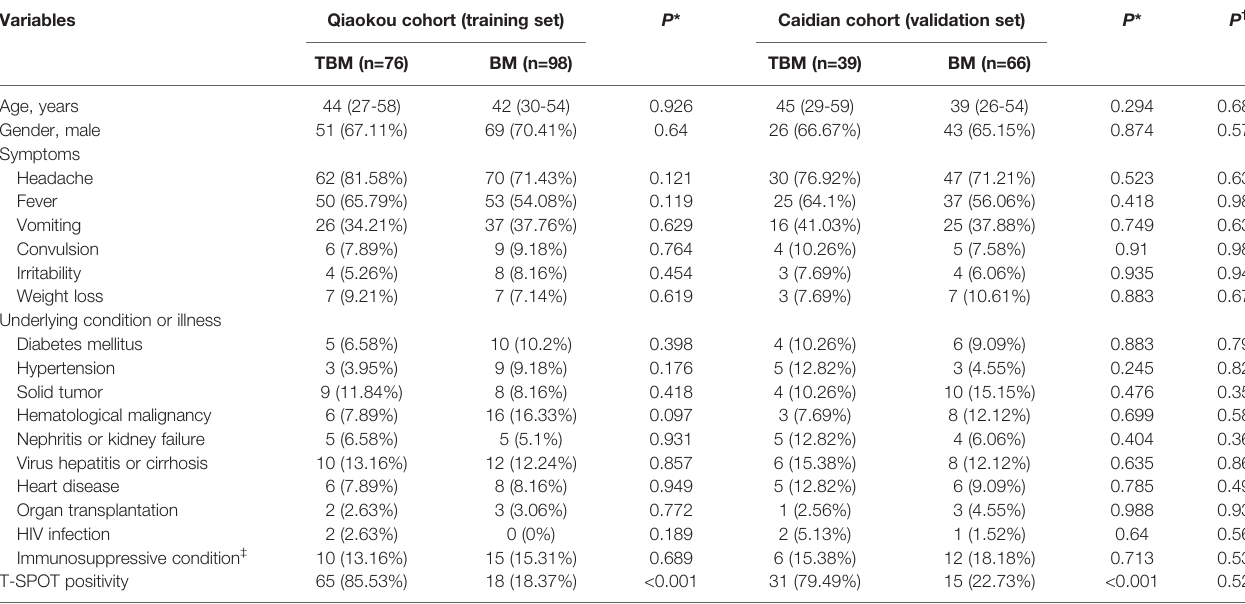
TABLE 1 | Demographic and clinical characteristics of recruited participants.